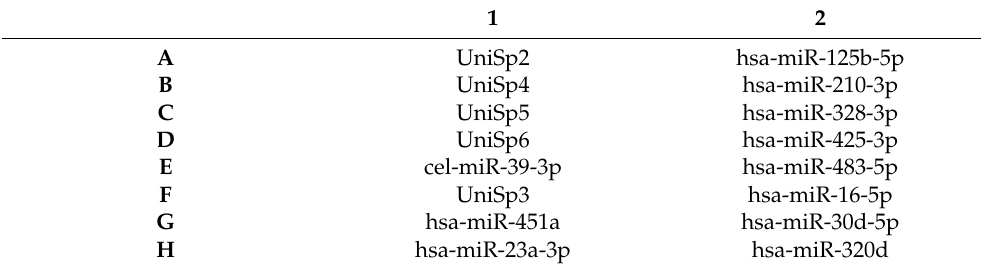
Table 7. miRCURY LNA Custom PCR Panels (Qiagen) primers on a 96-well plate. Columns 1 and 2 were repeated six times. Six samples were analyzed on a single 96-well